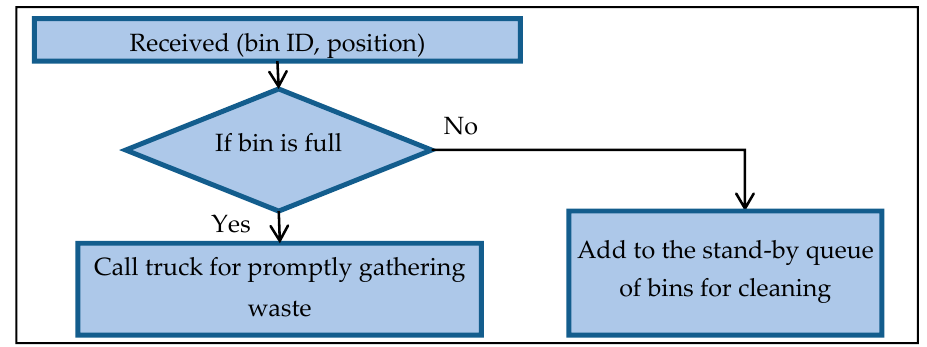
Figure 9. Proceedings for the decision-making process.